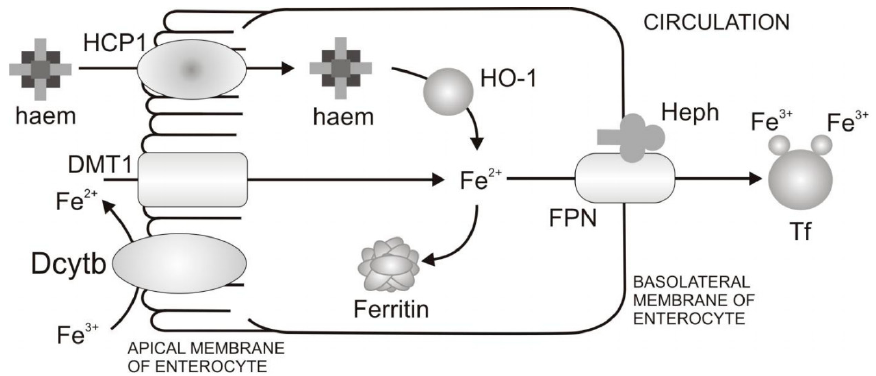
Figure 2. Mechanism of non-haem and haem iron absorption in duodenal cells. Non-haem iron from food is firstly reduced by the ferric reductase Dcytb yielding Fe 2+ , which afterwards enters the enterocytes via divalent metal transporter 1 (DMT1). On the other hand, haem is absorbed via haem carrier protein 1 (HCP1), subsequently broken down by HO-1, after which free Fe 2+ from haem joins a common cell iron pool with iron from the non-haem source. If body iron stores are high, iron may be stored in the cell complexed with ferritin as Fe 3+ and eventually lost when the cell is discarded from the intestinal villus tip. Otherwise, iron efflux into the circulation via the iron efflux transporter ferroportin (FPN), subsequently being re-oxidised through hephaestin (Heph) to enable loading into Tf, after which it is transferred to peripheral tissues that require iron.